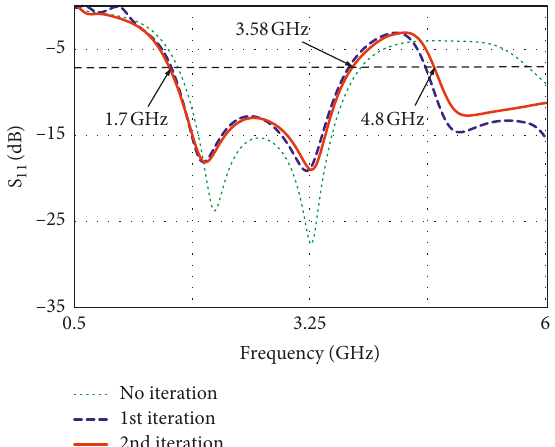
Figure 5: Combined simulated return loss for the antenna